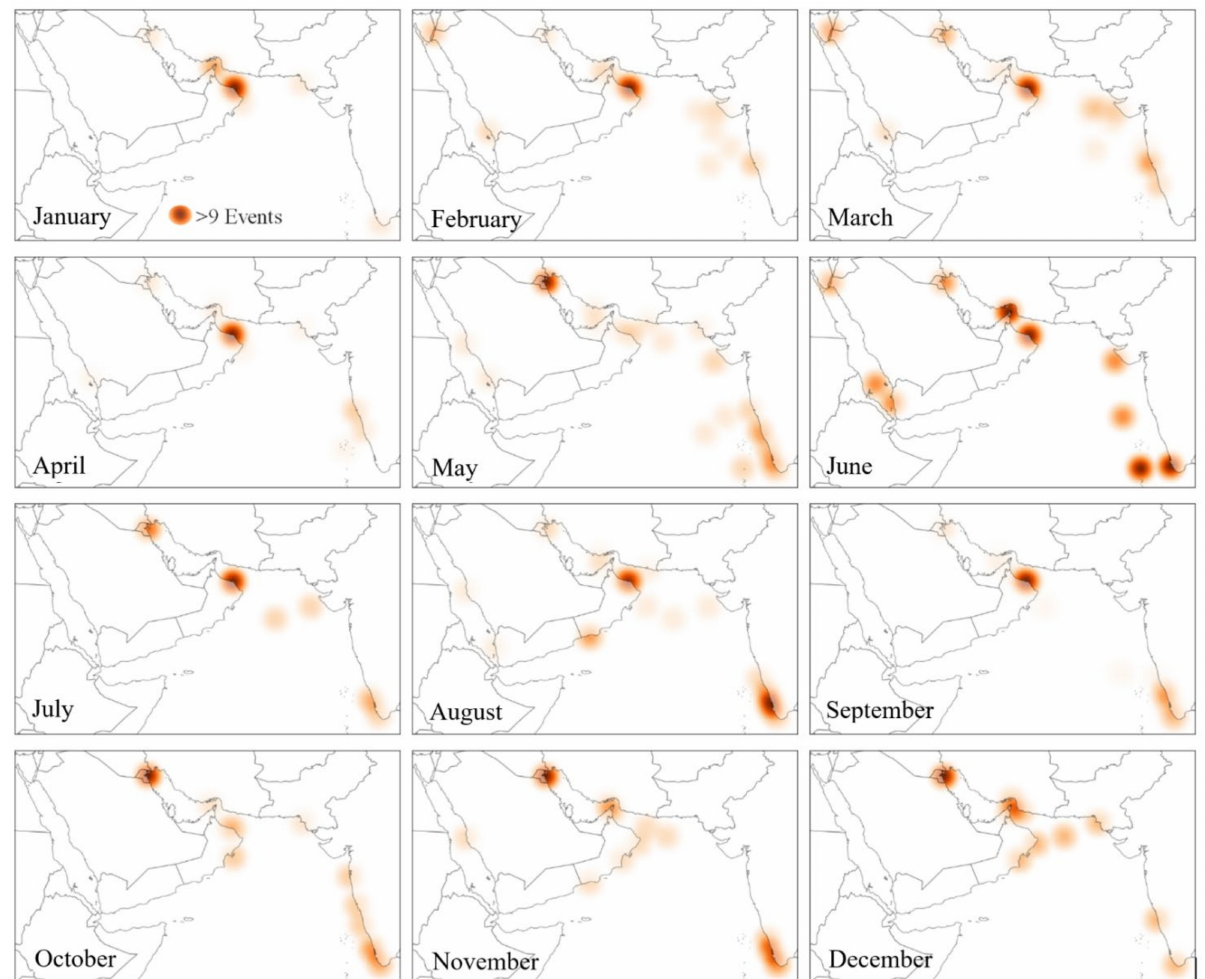
Figure 3. Monthly spatial distribution of algal blooms in the NIO during the whole period (1980–2010). The colors of the heat map circles represent the relative frequency of algal blooms in each location. The darker color represents the higher number of algal bloom events in the region over the three decades, and the lighter color represents less blooming events over the same